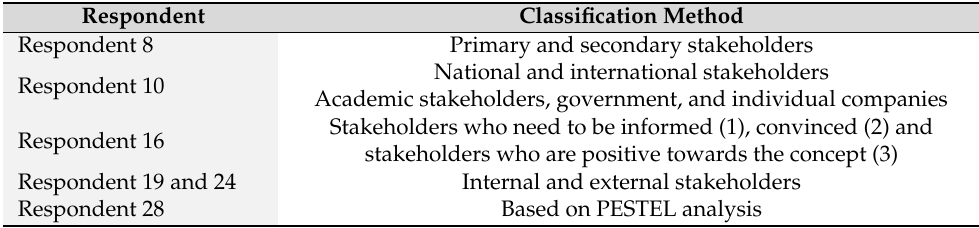
Table 7. Classification method used in 6